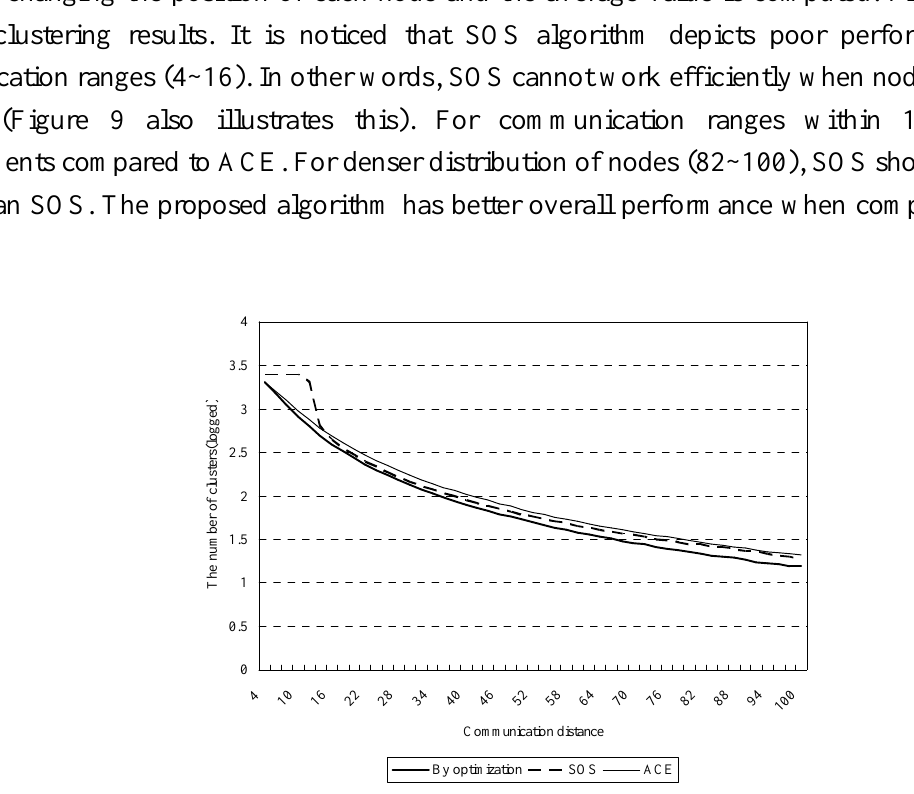
Figure 8. Performance results of three clustering